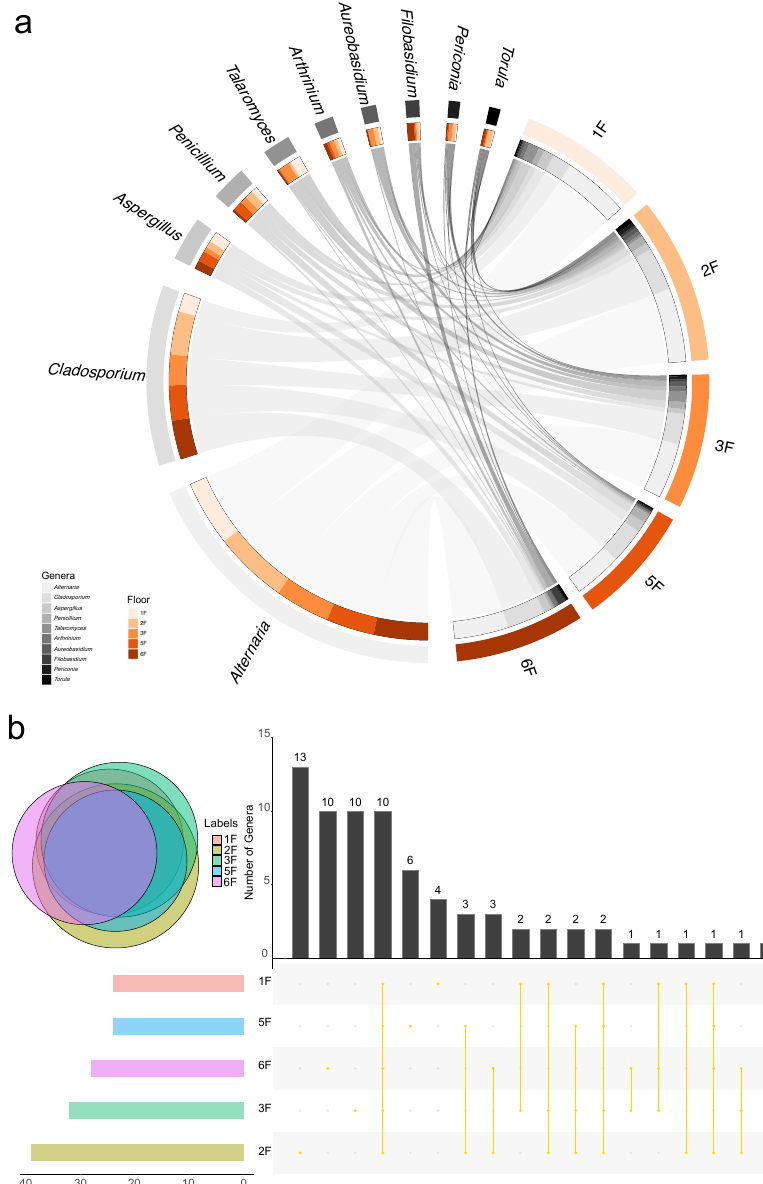
Figure 10. Fungal diversity and distribution in five sampling floors. ( a ) Distribution of top ten fungal genera in each floor visualized by Circos, the width of the bars indicates the relative abundance. ( b ) Number of common and unique genera detected between